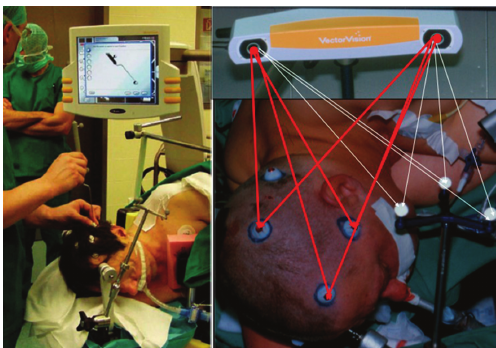
Figure 1: Typical preoperative registration using skin markers (so- called fiducials) and an optical camera system (BrainLab Vector Vision 2) correlating the presurgical image data sets to three-armed- star allowing intraoperative orientation of tracking devices in the surgical